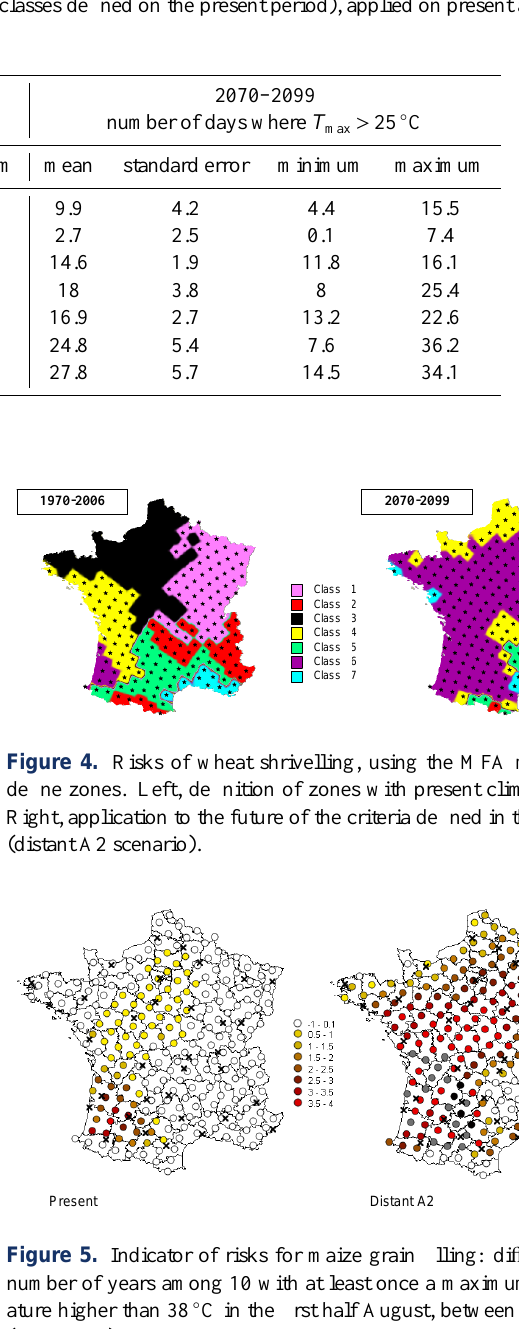
period (left) and the distant future period (right, distant A2). Now, the risk of stopping grain filling of maize is mainly present in the South-western part of France, but this event will occur in all the regions of France in the distant future. For wheat and maize, heat risks during grain filling will in- crease in the future, because of the increase of